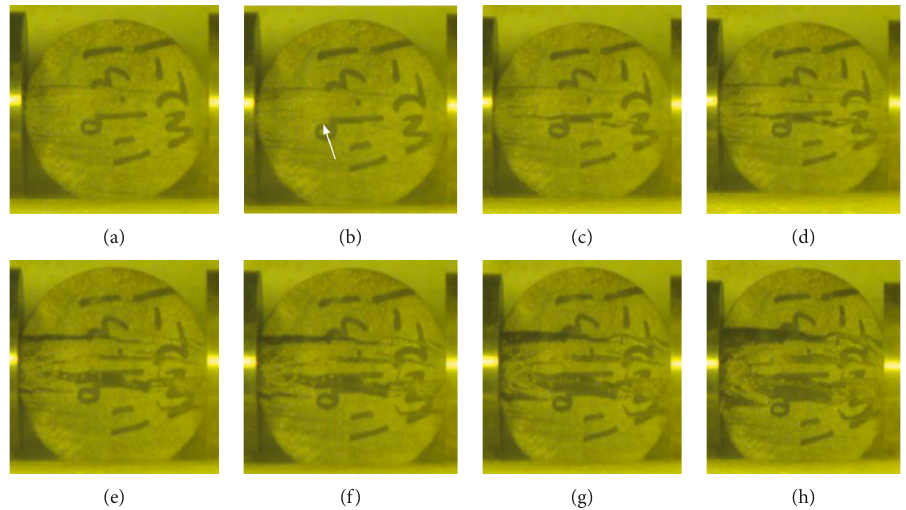
Figure 6: Failure processes of the specimen with a water content of 0.31%: (a) t � 0 μ s; (b) t � 55 μ s; (c) t � 110 μ s; (d) t � 165 μ s; (e) t � 275 μ s;